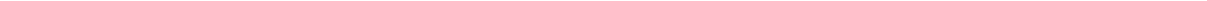
Fig. 2 Oxidative stress is involved in H2AX loss-induced neurobehavioral de fi cits. a , b N-acetyl-cysteine (NAC) treatment prevents disturbed general motor activity. Open- fi eld testing demonstrated that N-acetyl-cysteine (NAC 20 mM) signi fi cantly reduces impaired motor activity in H2AX knockout mice as measured by horizontal activity ( a ) or vertical activity ( b ), y -axis, number of beam breaks, x -axis, month. Data indicate the average of locomotor activity over 45 min each month. n = 5 (means ± s.e.m.) for H2AX wild type control group, n = 7 (means ± s.e.m.) for H2AX knockout control group, and n = 8 (means ± s.e.m.) for H2AX knockout treated with NAC. * P < 0.05. c Rotarod tests were also performed on mice used in a , b . Testing was conducted each month from weaning to 4 months, where each mouse was given three rounds of training, and latency to fall off the rotarod was measured at it accelerated from 4 to 40 rpm over 5 min; y -axis, the latency to fall off in seconds, x -axis, month. n = 5 (means ± s.e.m.) for H2AX wild type control group, n = 7 (means ± s.e.m.) for H2AX knockout control group, and n = 8 (means ± s.e.m.) for H2AX knockout treated with NAC. * P < 0.05, ns non-signi fi cant ( P = 0.1482). d , e H2AX deletion leads to accrued ROS levels. Control cells (H2AX WT), as well as mutant mouse embryonic fi broblasts (H2AX KO) were incubated with dihydroethidium (DHE) and used for ROS detection by microscopy. Cells were counterstained using Hoechst ( d ). The raw DHE